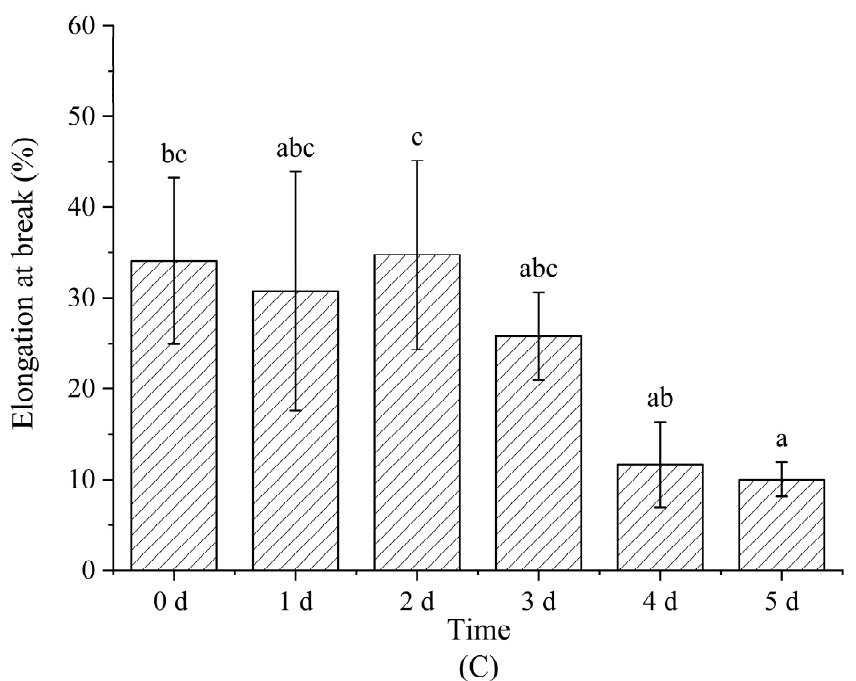
Figure 10. The elastic modulus (A), tensile strength (B), and elongation at break (C) of gelatin/zein/glucose nanofibers after Maillard reactions conducted at 60 °C and 50% RH for 0~5 days. Values with different superscript letters are significantly different ( P < 0.05).